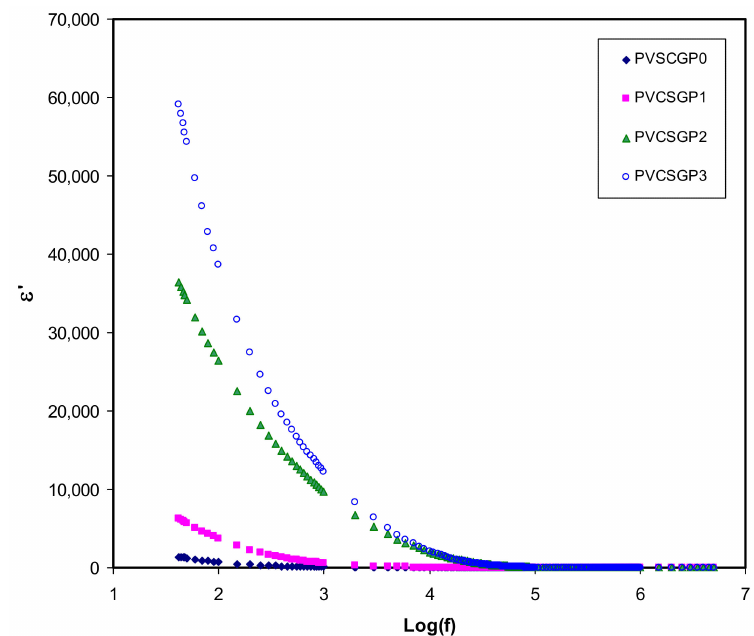
Figure 3. Dielectric constant versus log (f) for all polymer-blend electrolytes.